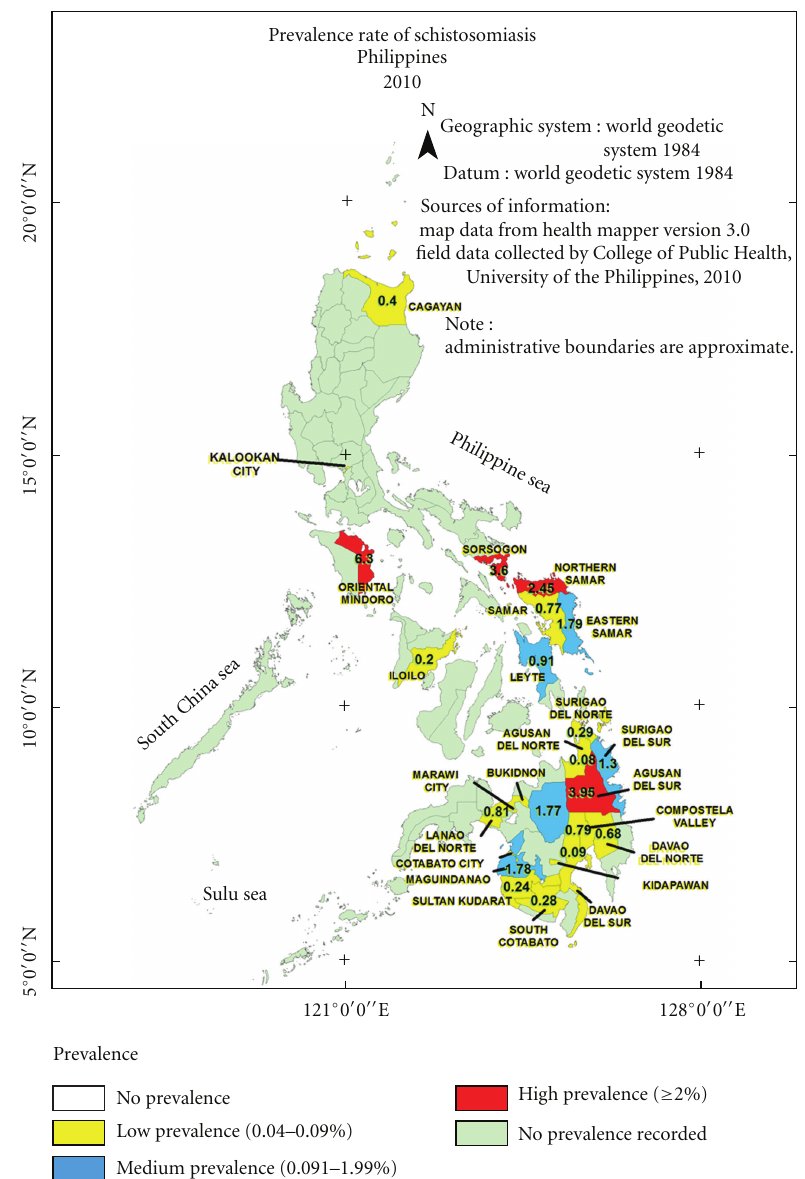
Figure 4: Field data collected by the schistosomiasis research team, College of Public Health, University of the Philippines Manila 2005–2008.